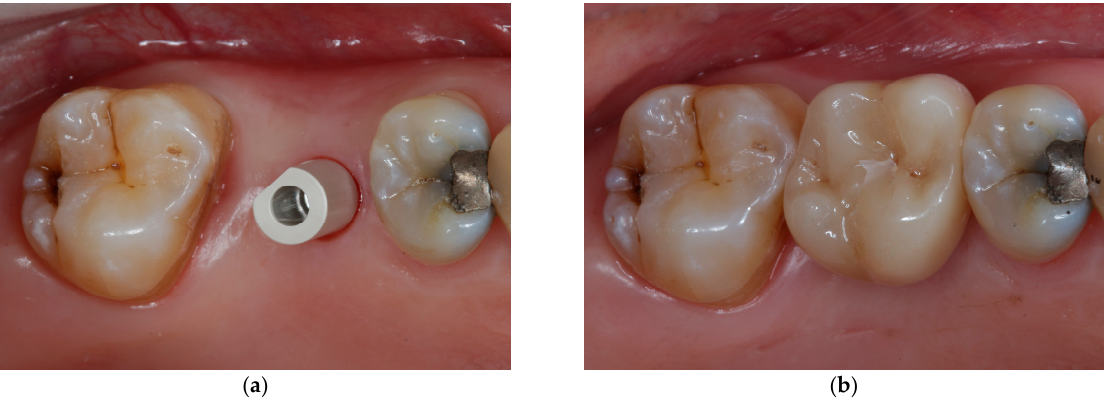
Figure 3. Final restoration: ( a ) digital impression taking; ( b ) final restoration with a screw ‐ retained single crown.